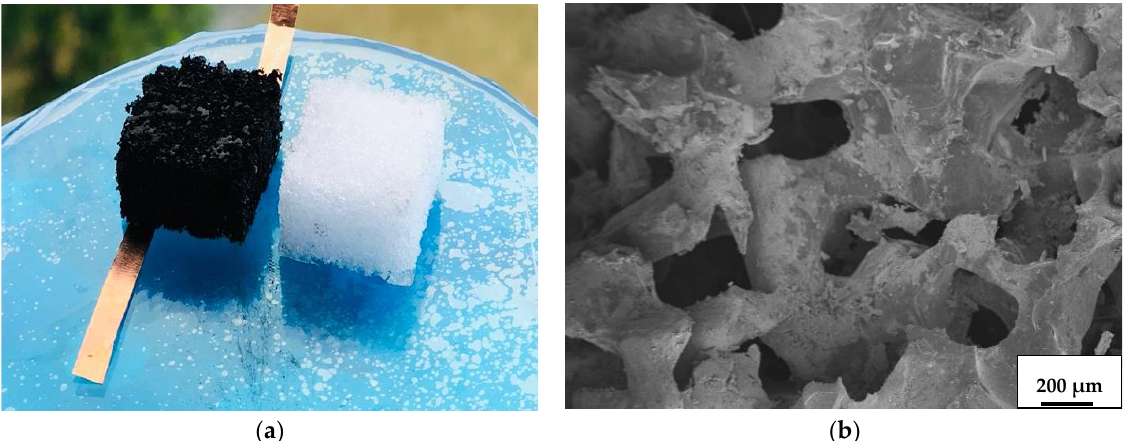
Figure 1. ( a ) Optical image of the piezoresistive sponge before and after coating with the conductive network; ( b ) scanning electron microscope (SEM) images of the tactile sensor.